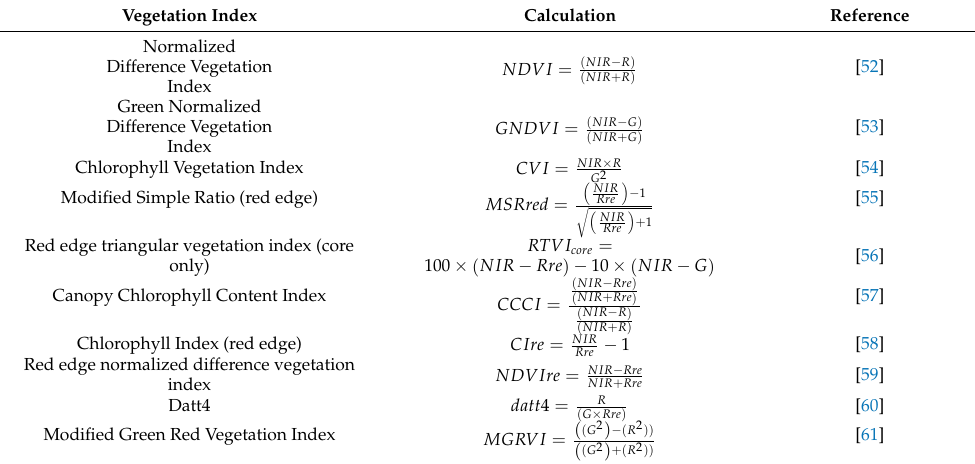
G: Green band; R: Red band; Rre: Red Edge band; NIR: Near Infrared